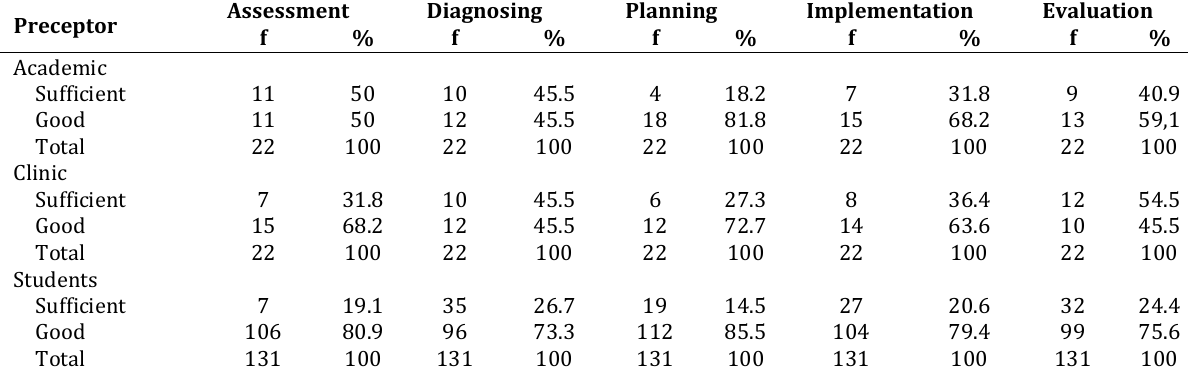
Table 2. Nursing Care Implementation Evaluation Assessment Diagnosing Planning Preceptor